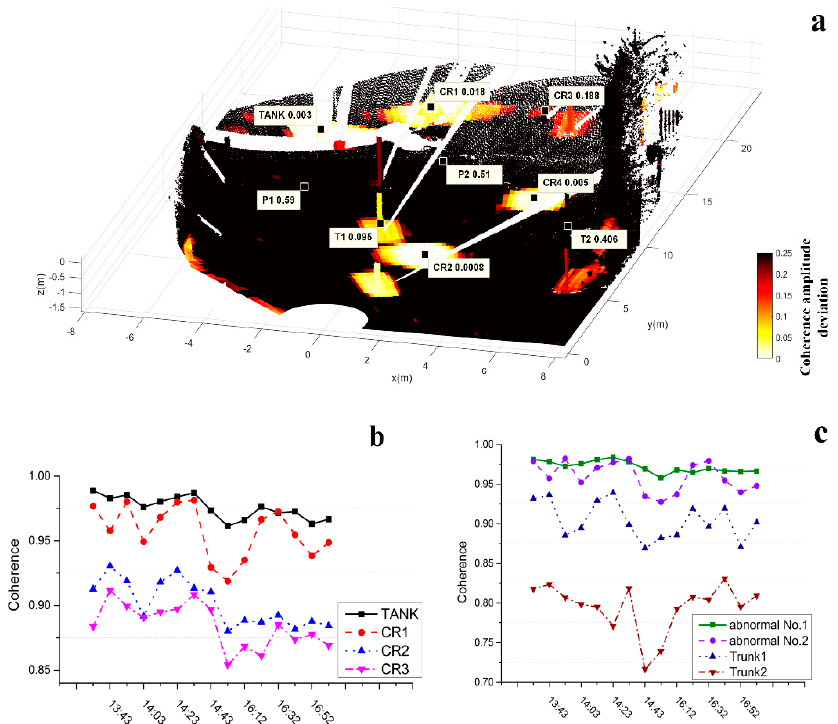
Figure 14. 3D coherence analysis ( a ) DA map projected to point cloud, colors identify the DA less than 0.25. DA values of some points corresponding to points in ( b , c ) are shown. ( b ) Coherence curve of artificial targets over time; ( c ) Anomalous areas in Figure 7 where coherence changes with time, abnormal No. 1 and abnormal No. 2 correspond to P1 and P2 in panel ( a ).